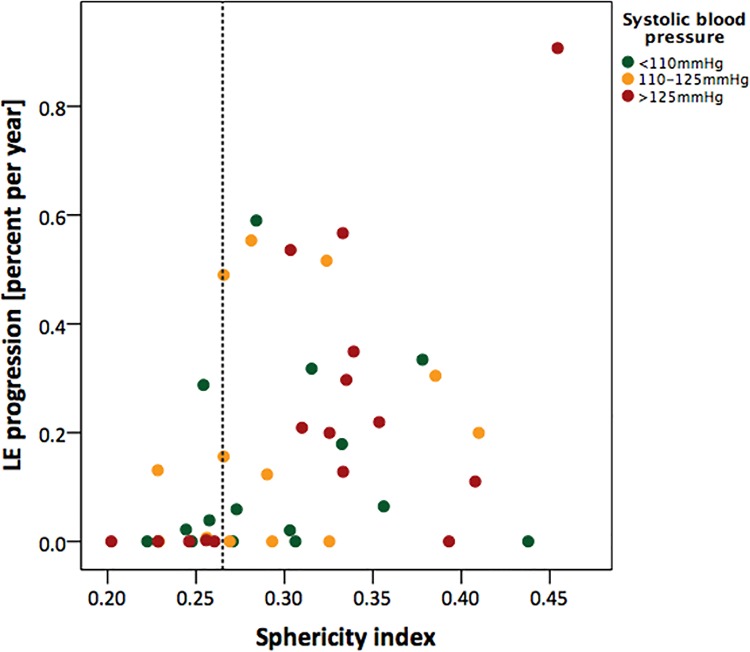
Scatter plot of annual progression rate of myocardial fibrosis versus the alterations in geometry.On the x-axis values of the sphericity index (SI, parameter for geometry) and on the y-axis the annual progression of late enhancement (LE, parameter for fibrosis) is displayed. The size of the red dots represents the systolic blood pressure (SBP) at baseline. The vertical line indicates the pathological value of the SI. Note the appearance of high SI in combination with elevated SBP and high progression rate. EDV; End-diastolic volume.